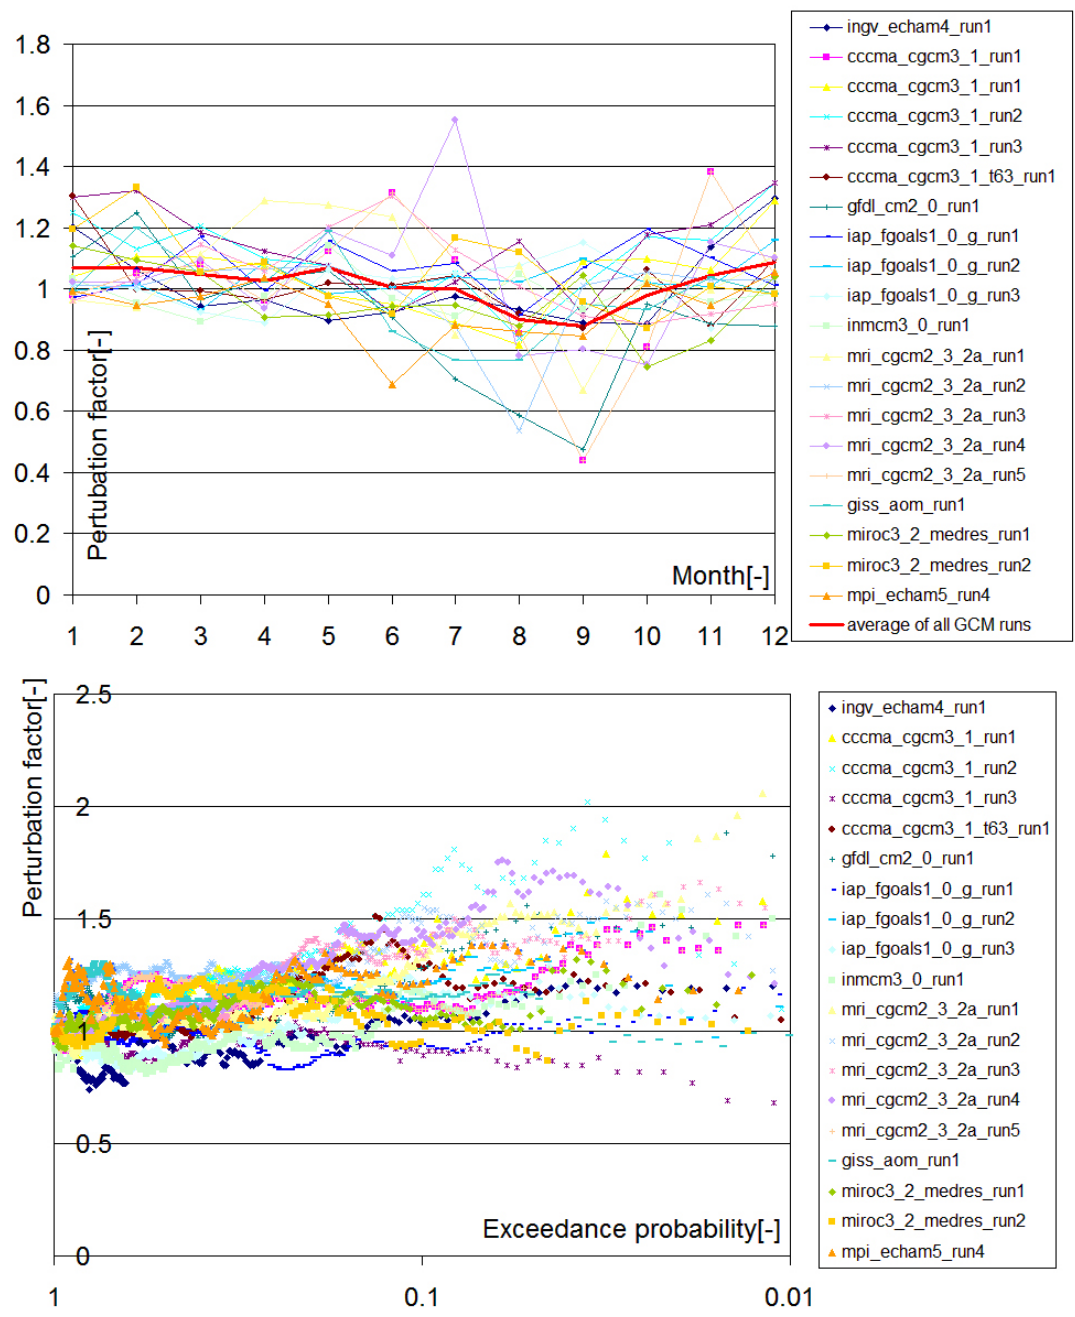
Fig. 7. Perturbation factors for wet day precipitation intensity extremes: mean factors for precipitation quantiles higher than the quantile with exceedence probability 0.1 in each month (top) and perturbation factor versus exceedance probability for February (bottom). wet/dry days, obviously no wet day frequency perturbations Again, high, mean, and low levels of changes were consid- were considered. Only mean monthly changes (MV ap- ered, to account for the entire ensemble range of GCM runs proach) were implemented. The changes are for temperature defined as absolute differences (between future and control perature change for the A2, A1B and B1 emission periods), while they are defined as relative changes (ratios of the values during future versus control periods) for PET.